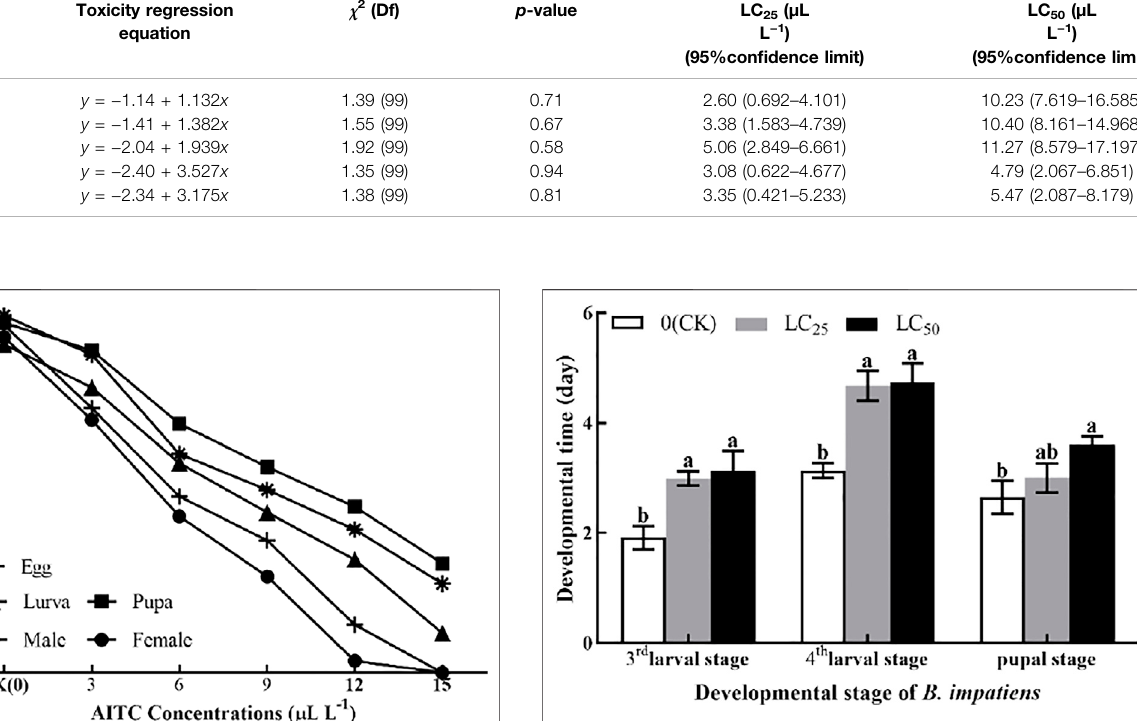
FIGURE 1 | Effectof different concentrations ofAITC on the survival rate of B. impatiens .